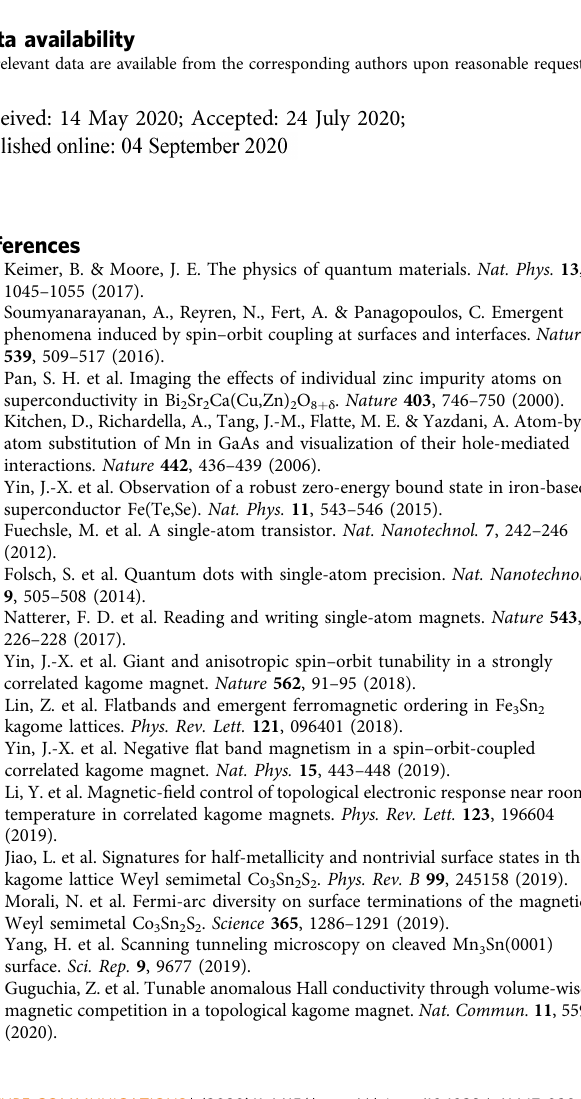
Data availability